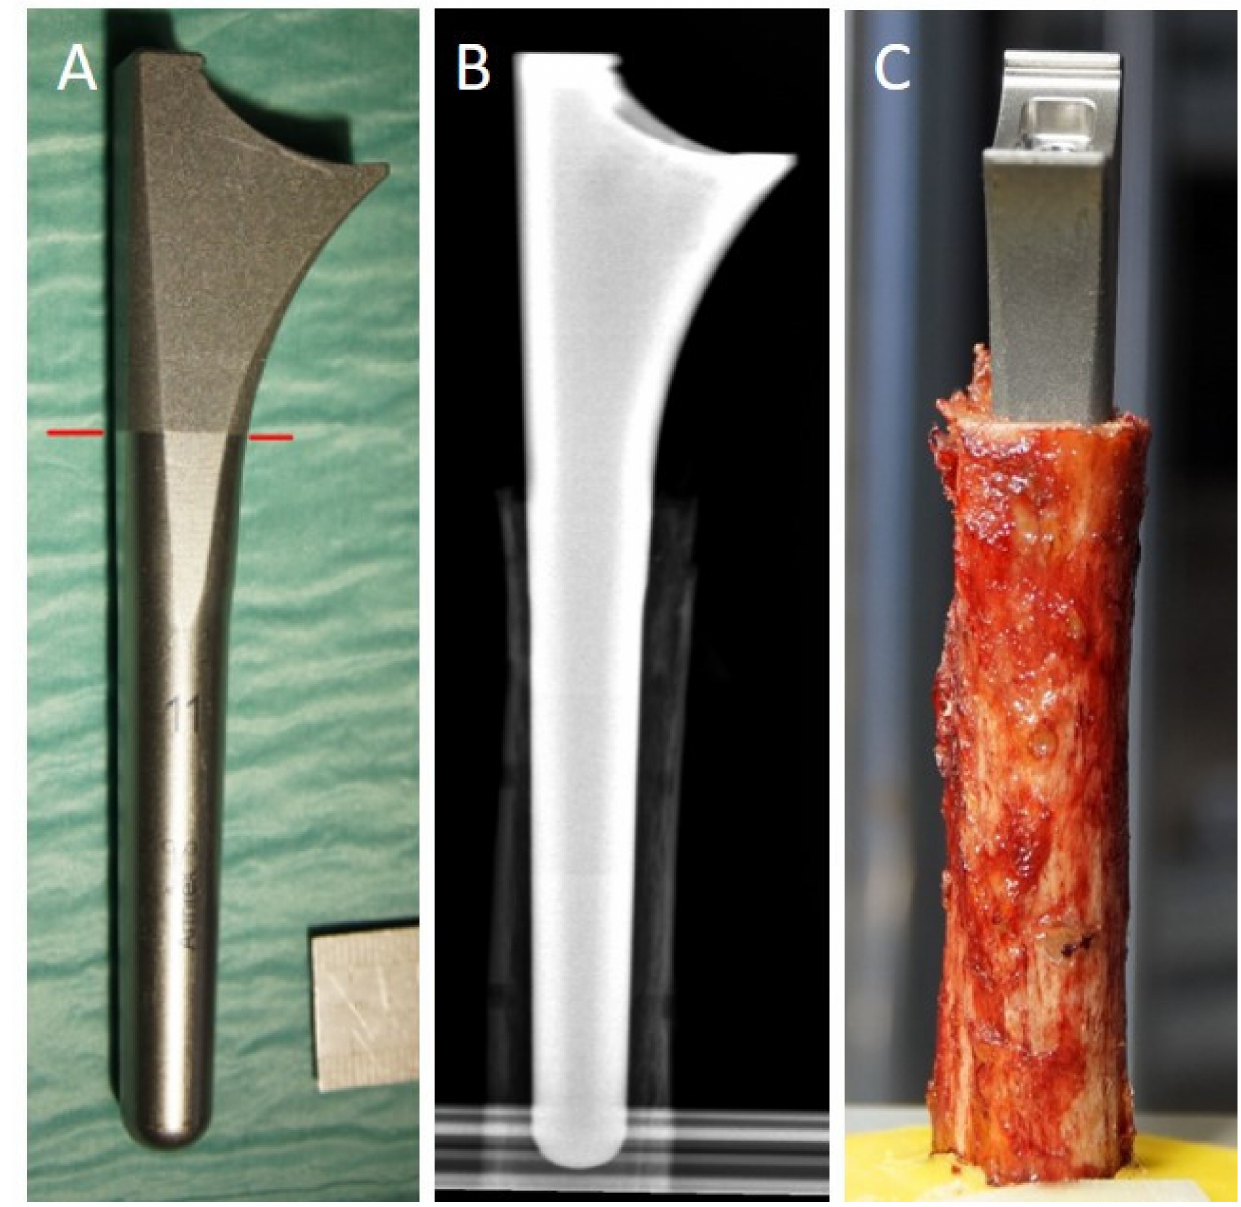
Figure 3. ( A ) Univers Revers stem (size 11), red line marks the junction between dia- and meta-physis. ( B ) X-ray prior to biomechanical testing confirming the correct stem size in relation to the humeral shaft. ( C ) Clinical picture prior to the start of testing confirming the correct position of the dia-/meta-physal junction in relation to the humeral shaft